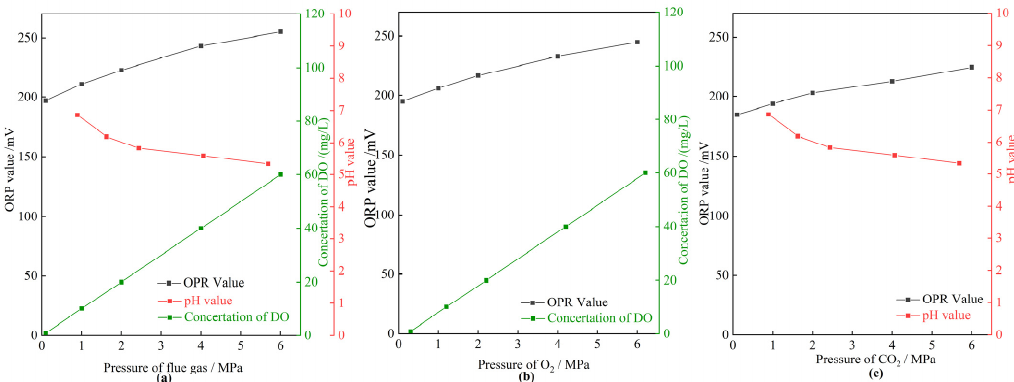
Figure 13. The properties of the HPAM solution in different pressures of gases. ( a ) The OPR value, concentration of DO, and pH value as a function of pressure of flue gas; ( b ) the OPR value and concentration of DO as a function of pressure of O 2 ; ( c ) the OPR value and pH value as a function of pressure of CO 2 .